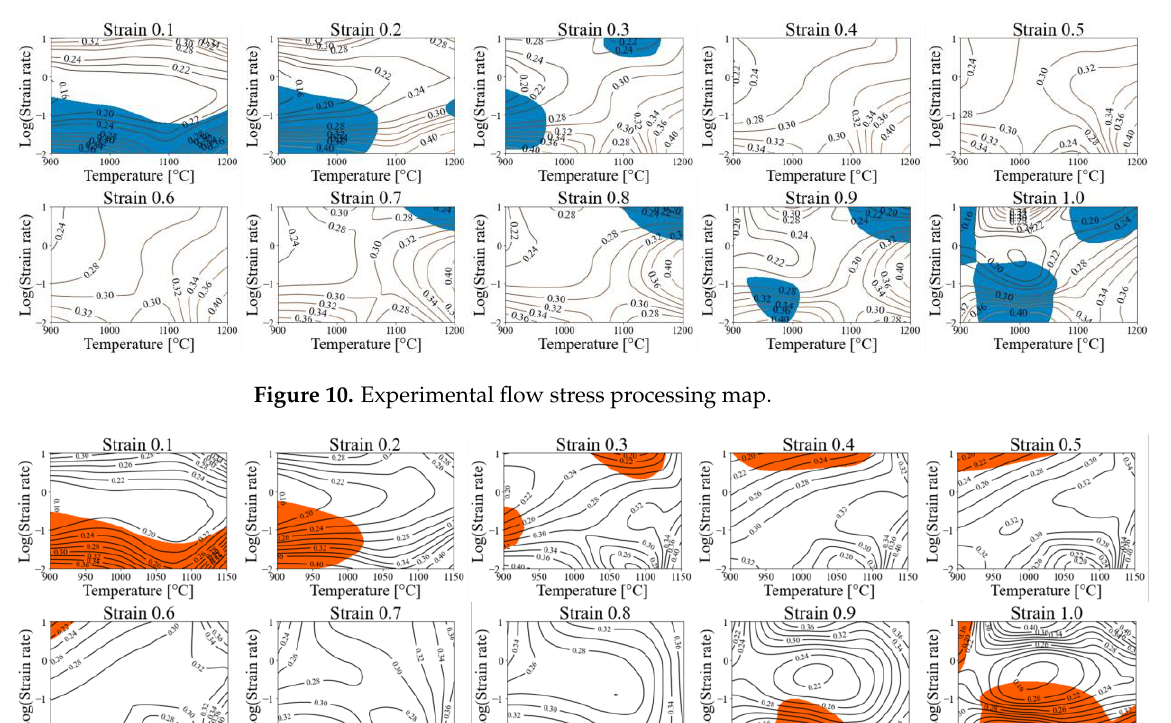
Figure 11. Corrected flow stress processing map.